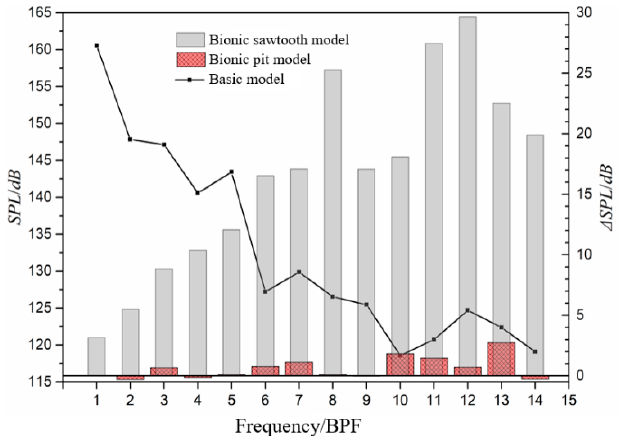
Figure 12. Sound pressure level at blade-passing frequency (BPF) and noise reduction value of bionic structure. bionic